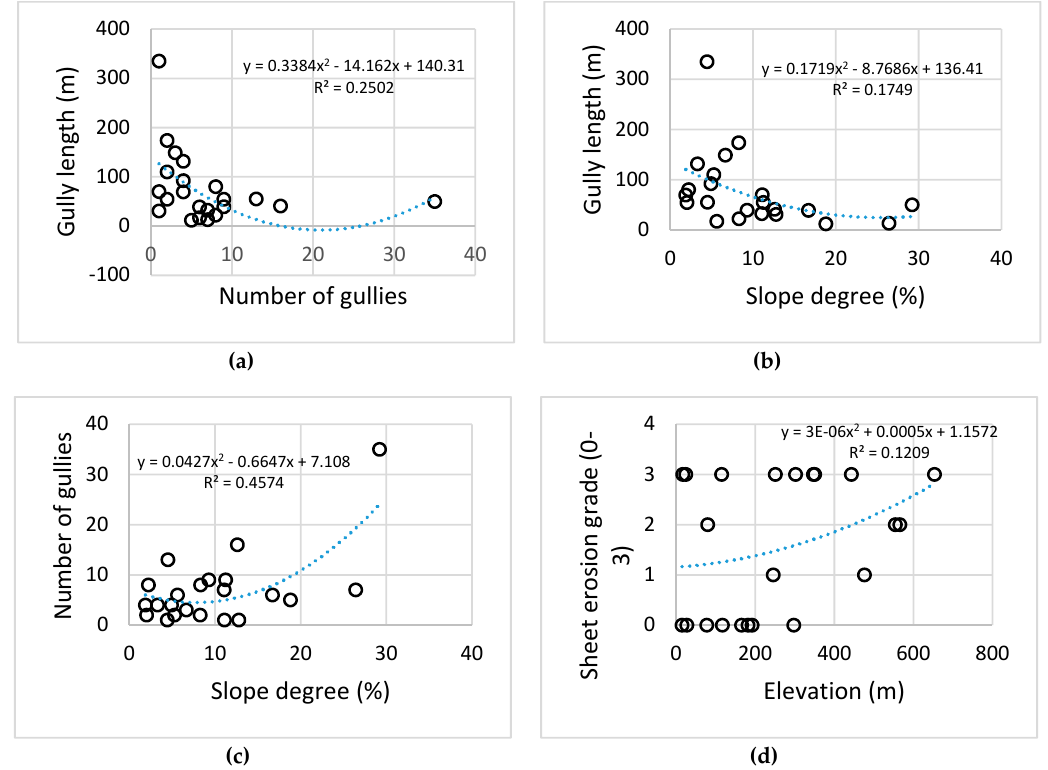
Figure 8. Trend plots: negative trend between total gully length and number of gullies ( a ) and between gully length and slope degree ( b ); positive trend between number of gullies and slope degree ( c ) and sheet erosion grade and elevation ( d ).